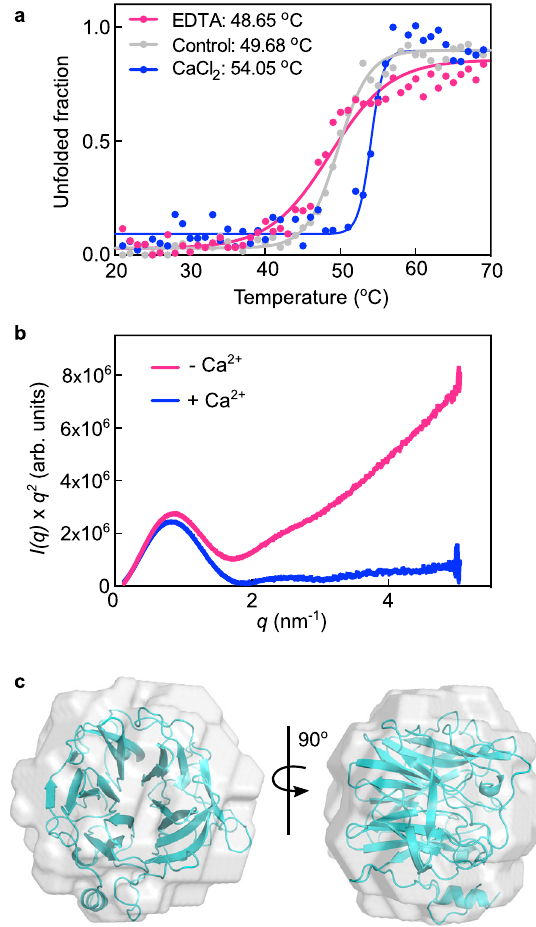
Fig. 4 Ca 2 + increases XacGH43_1 stability. a Thermal denaturation pro fi le of XacGH43_1, monitored at 228 nm by circular dichroism spectroscopy without additives (control — gray), with EDTA (pink) or CaCl 2 (blue). The melting temperatures (T m ) are indicated for each sample. b Kratky plot 93 obtained for XacGH43_1 samples without (control — pink) or with CaCl 2 (blue). The dataset collected with CaCl 2 were used to generate an ab initio envelope. c XacGH43_1 crystal structure fi tted into the SAXS envelope. Source data are provided as a source data fi